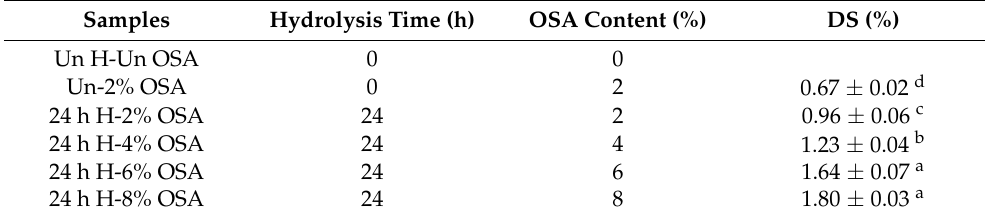
Table 2. The effects of different concentrations of OSA on the degree of substitution.